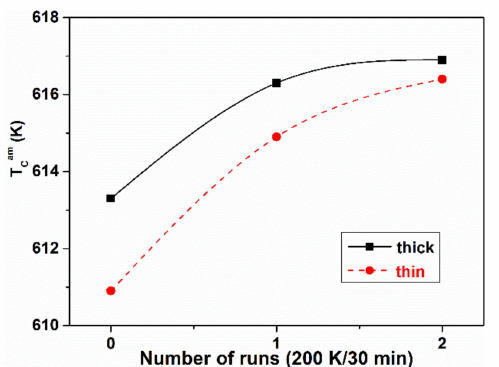
Figure 13. Curie temperature T Cam for slowly and rapidly cooled (thick and thin) Fe 40 Ni 40 (SiB) 20 ribbons and the change during cyclic reheating to the Curie temperature (between two measurements isothermal heat treatments at 473 K for 30 min were applied) adapted from [82], with permission from author, 2006.